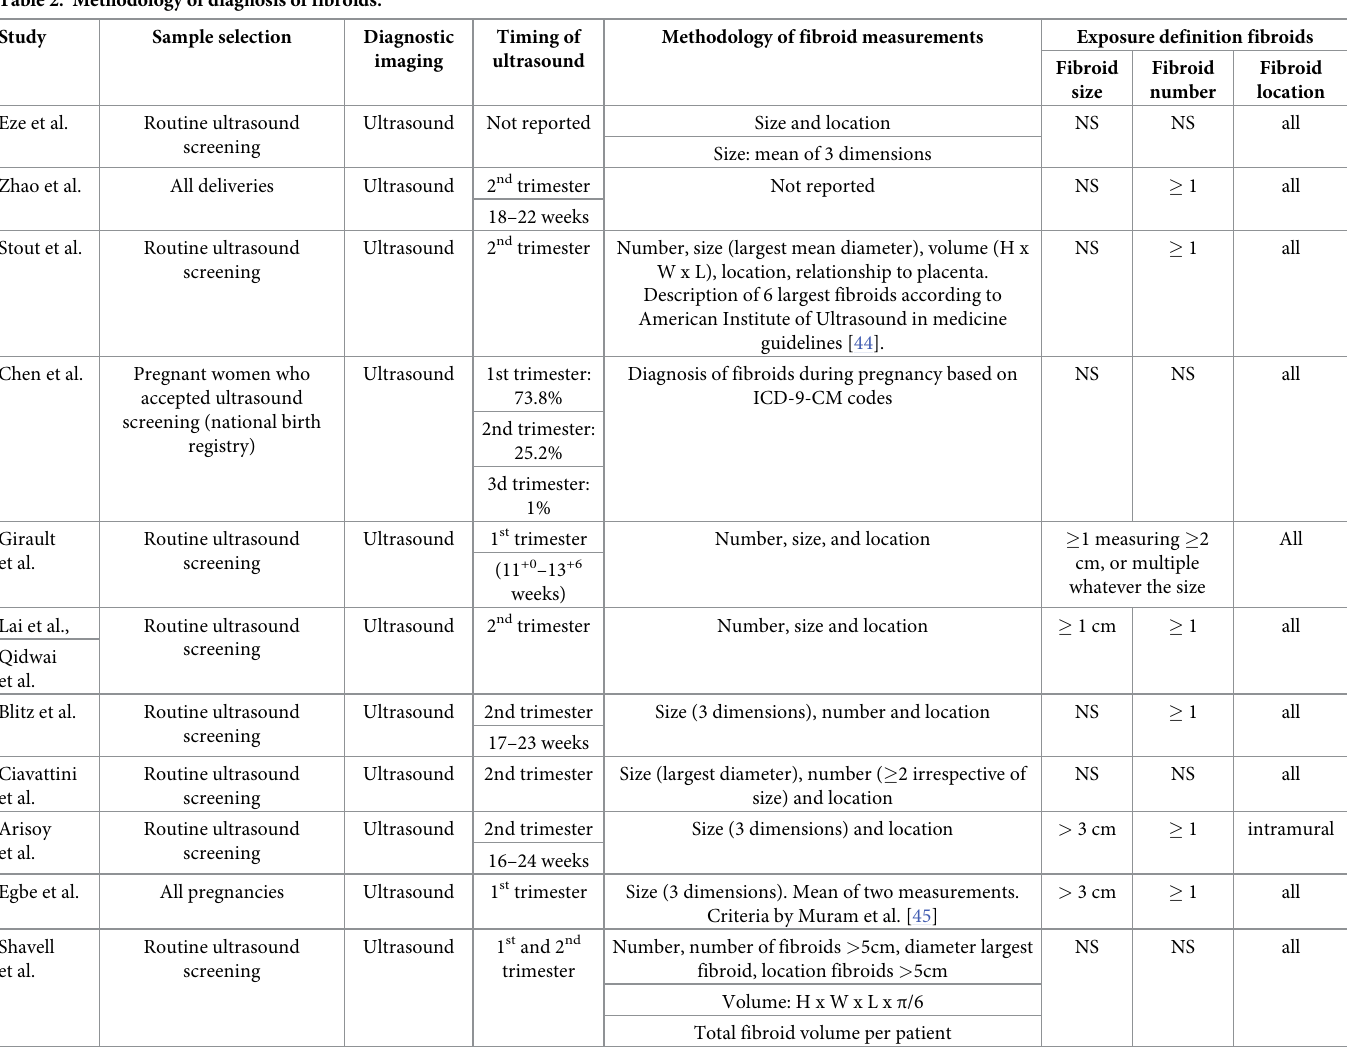
Table 2. Methodology of diagnosis of